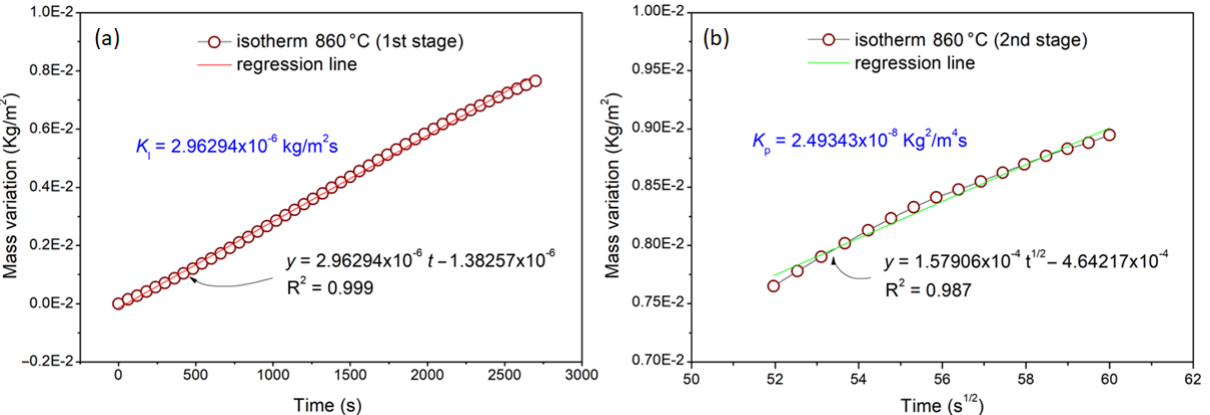
Figure 8. Mass variation per unit surface area as a function of the exposure time for the Ni-based alloy at 860 °C to determine the linear ( 𝐾 𝑙 ) and parabolic ( 𝐾 𝑝 ) oxidation rate constants: ( a ) first stage and ( b ) second stage. Table 1. Kinetic parameters determined from the thermogravimetric analysis of the Ni-based alloy under study.